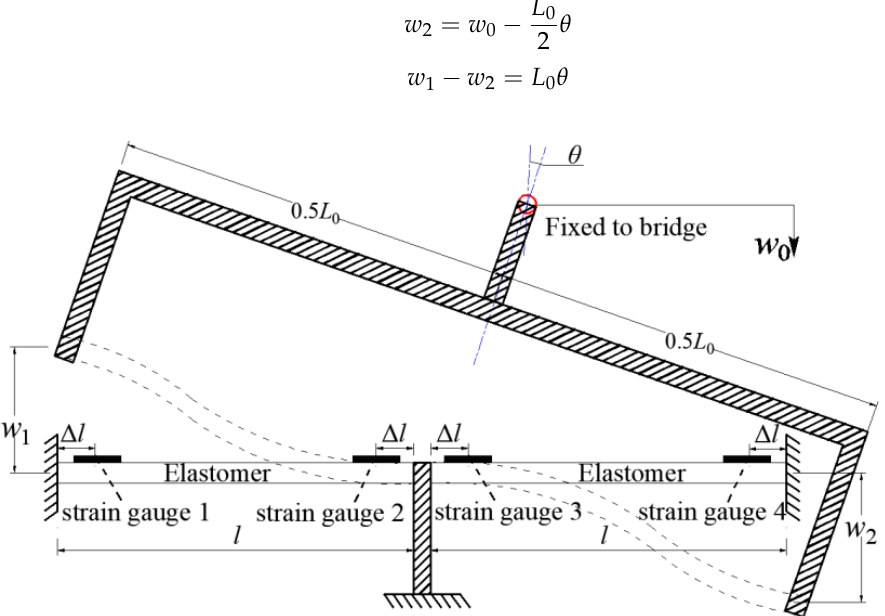
Figure 2. Deformation illustration of the inclinometer under bridge rotation.